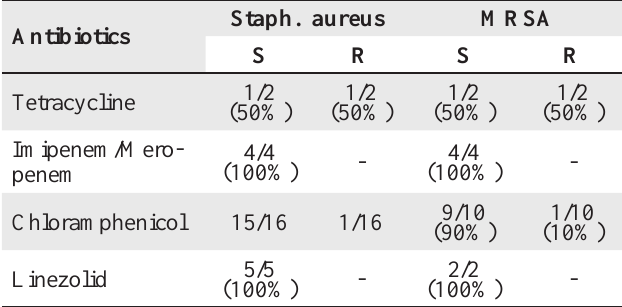
Table 3 : Antibiotic sensitivity of E. coli and Klebsiella in post cesarean SSI E.coli ( n =5) Klebsiella ( n =1) Antibiotic